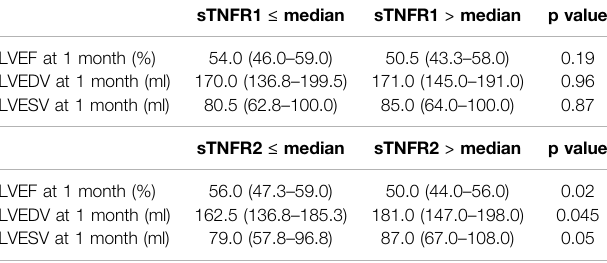
TABLE 2 | Cardiac remodeling data according to sTNFR